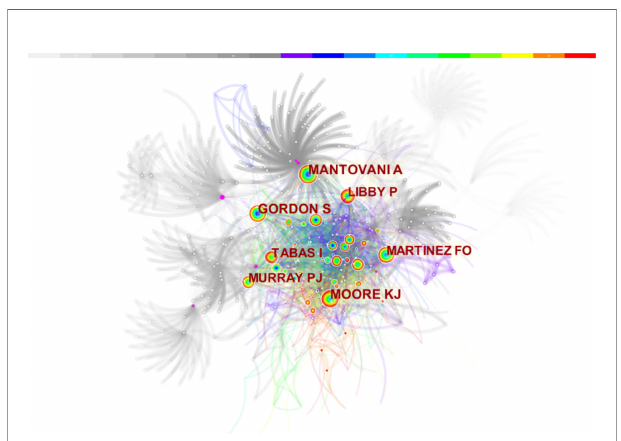
FIGURE 3 | Co-cited author co-occurrence map of macrophage polarization in AS research.